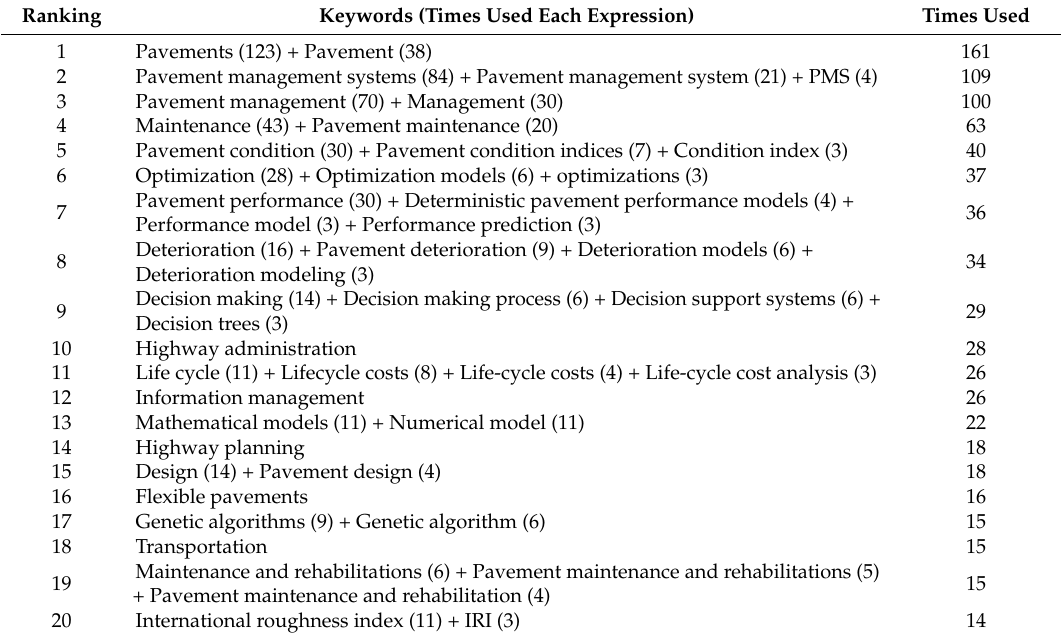
Table 7. The top 20 most frequently used keywords during the 2012–2013 period.